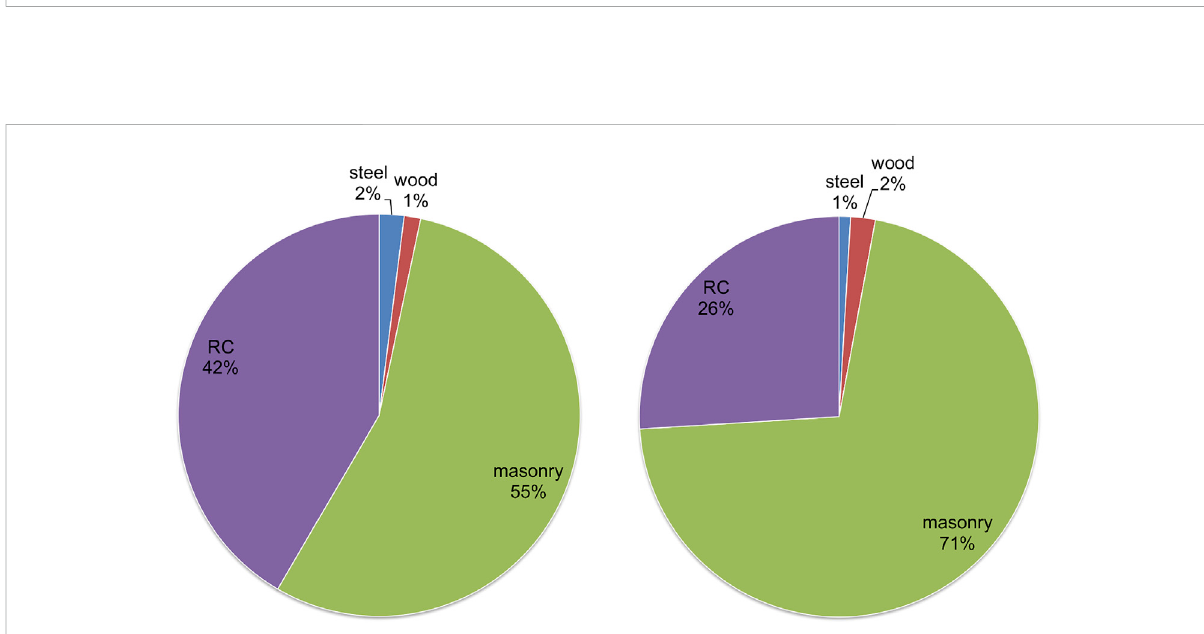
Frontiers in Built